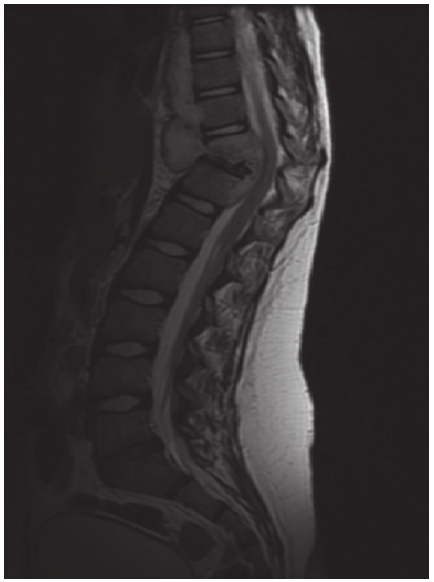
Figure 2: Contrasted magnetic resonance imaging (MRI) of the spine shows kyphotic destruction of thoracic vertebrae T10, T11, and T12 with abnormal high signal on T2 and low signal on T1 with heterogeneous enhancement in addition to a large heterogeneous paravertebral multiloculated prevertebral and paraspinal abscess extending from T7 through T12 with a peripheral thick wall that has low T2 and high T1 signal with intense enhancement. These are associated with an epidural collection and retropulsed collapsed T11, which result in complete attenuation of the anterior sub- arachnoid spaces and compression of the distal